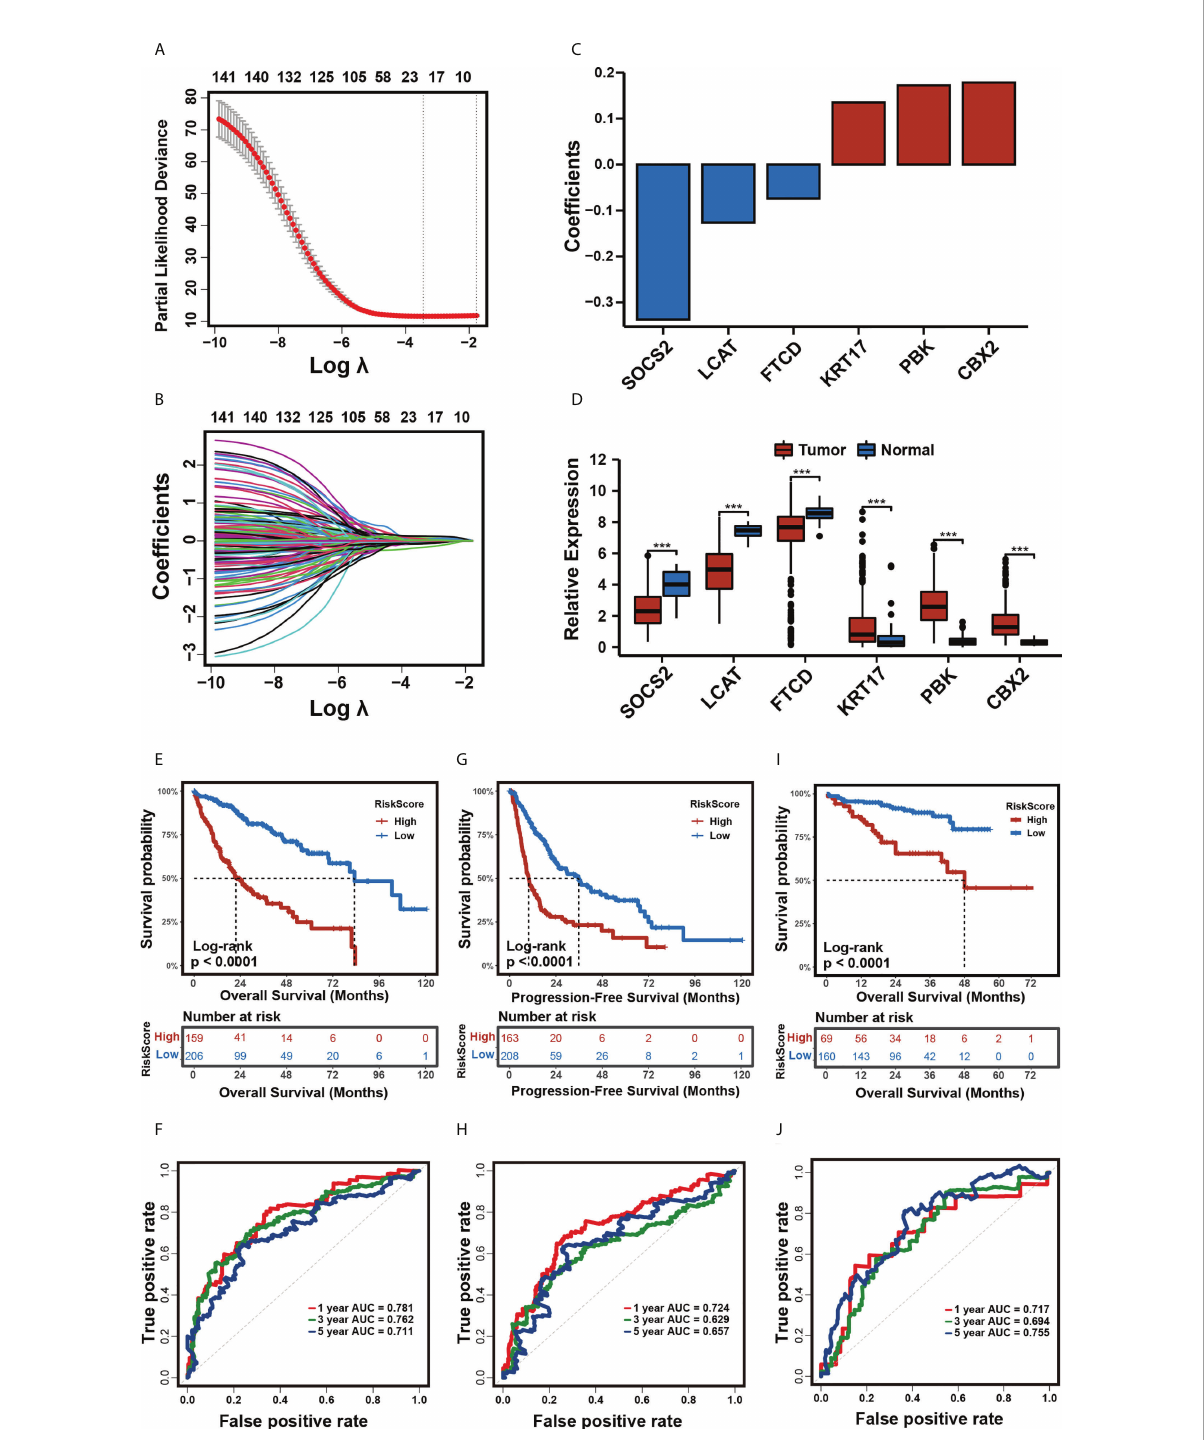
FIGURE 4 Construction of the prognostic risk model. (A, B) The least absolute shrinkage and selection operator (LASSO) regression was performed, calculating the minimum criteria. (C) . Coef fi cients plot of six selected genes. (D) . Differential expression of six selected genes in tumor and normal tissues in TCGA-LIHC cohort. (*** p<0.001). (E, F) Kaplan-Meier analysis for OS (E) and time-dependent ROC curve (F) of the risk score in the TCGA-LIHC cohort. (G, H) Kaplan-Meier analysis for DFS (G) and time-dependent ROC curve (H) of the risk score in the TCGA-LIHC cohort. (I, J) Kaplan-Meier analysis for OS (I) and time-dependent ROC curve (J) of the risk score in the ICGC